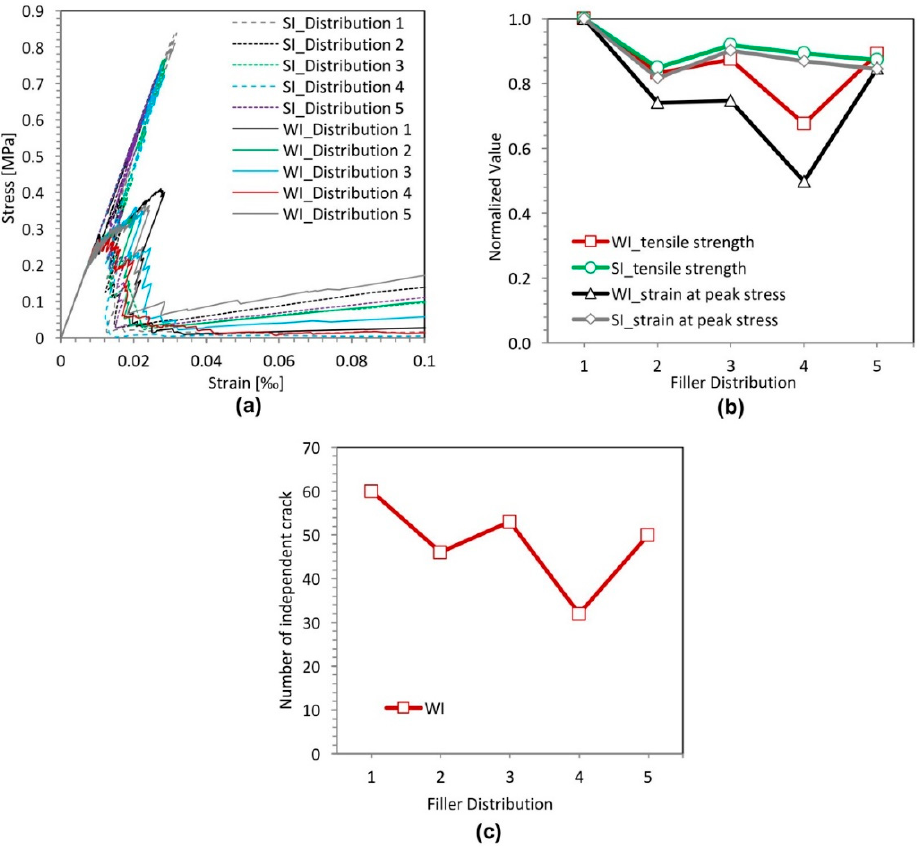
Figure 5. Simulated results of the filler distribution effect analyses for specimens with a strong interface (SI) and a weak interface (WI). ( a ) Stress-strain relation; ( b ) variation of the strength and the strain at peak stress; ( c ) number of independent cracks.